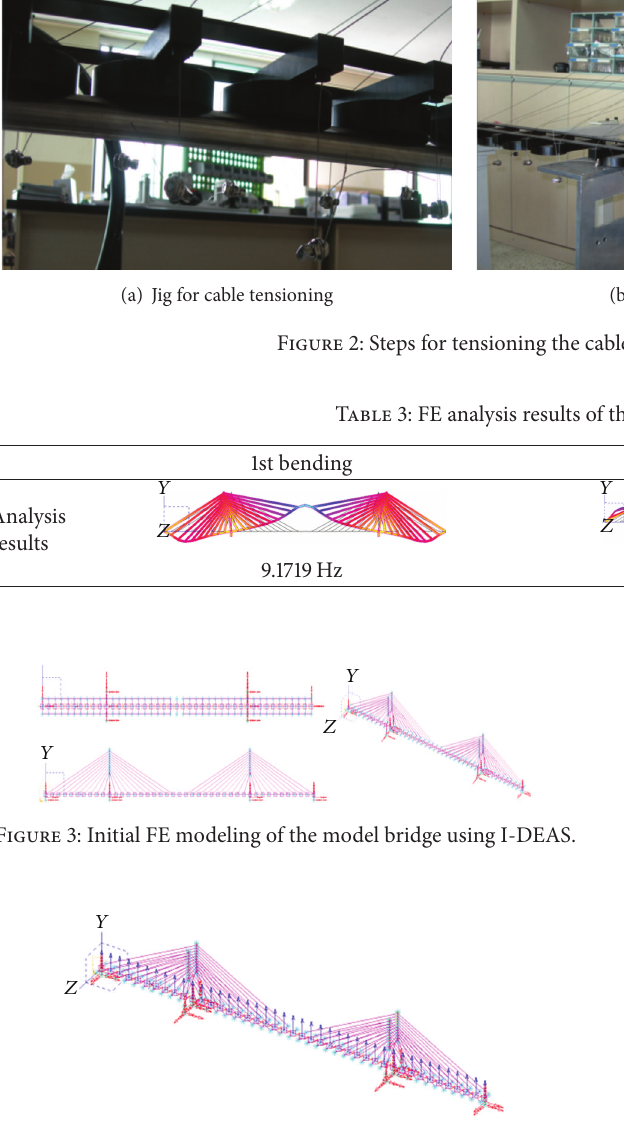
Figure 4: Initial FE modeling of the model bridge using I-DEAS (39